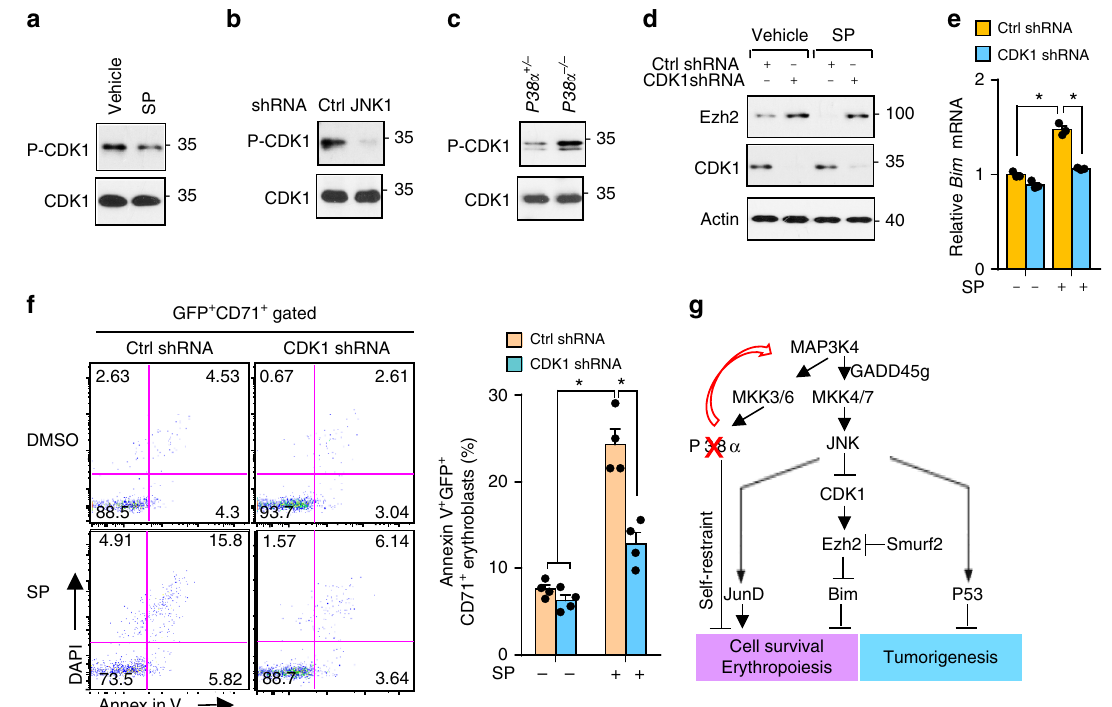
Fig. 7 JNK-mediated Cdk1 inhibition stabilizes Ezh2 and supports erythroblasts. a , b Tyr-15 phosphorylation of Cdk1 in SP600125-treated ( a ) or in JNK1- silenced ( b ) human erythroblasts by immunoblotting. c Phosphorylation of Tyr-15 of Cdk1 in P38 α + / − and P38 α − / − erythroblasts. d – f Human erythroblasts transduced with control or cdk1-speci fi c shRNA and treated with vehicle or SP600125. Protein levels of Ezh2 and Cdk1 by immunoblotting ( d ), mRNA expression of Bim by q-PCR ( e ), and representative fl ow cytometry pro fi le (left) and quanti fi cation (right) of apoptotic human erythroblasts ( f ) ( n = 4). g Schematic outlining a proposed mechanism mediating rewired JNK activation due to lack of P38 via Map3k4 and their downstream targets regulating erythropoiesis. Blots are representative of three independent experiments. Data are shown as mean ± s.e.m. * P < 0.05 (two-tailed unpaired Student ’ s t